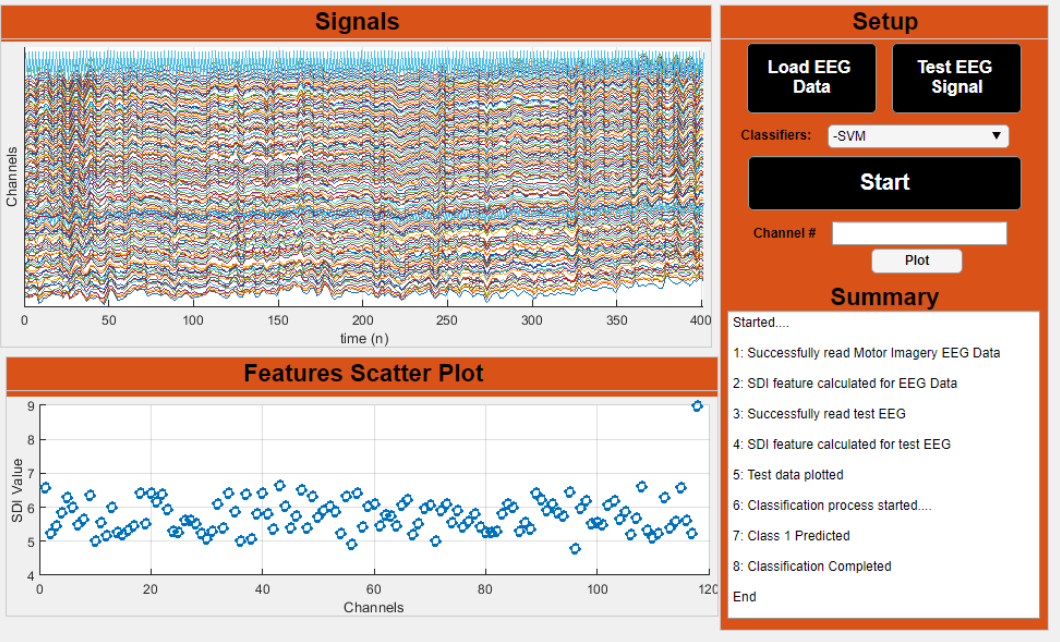
Figure 10. A display of CADMMI-SDI portraying all features and